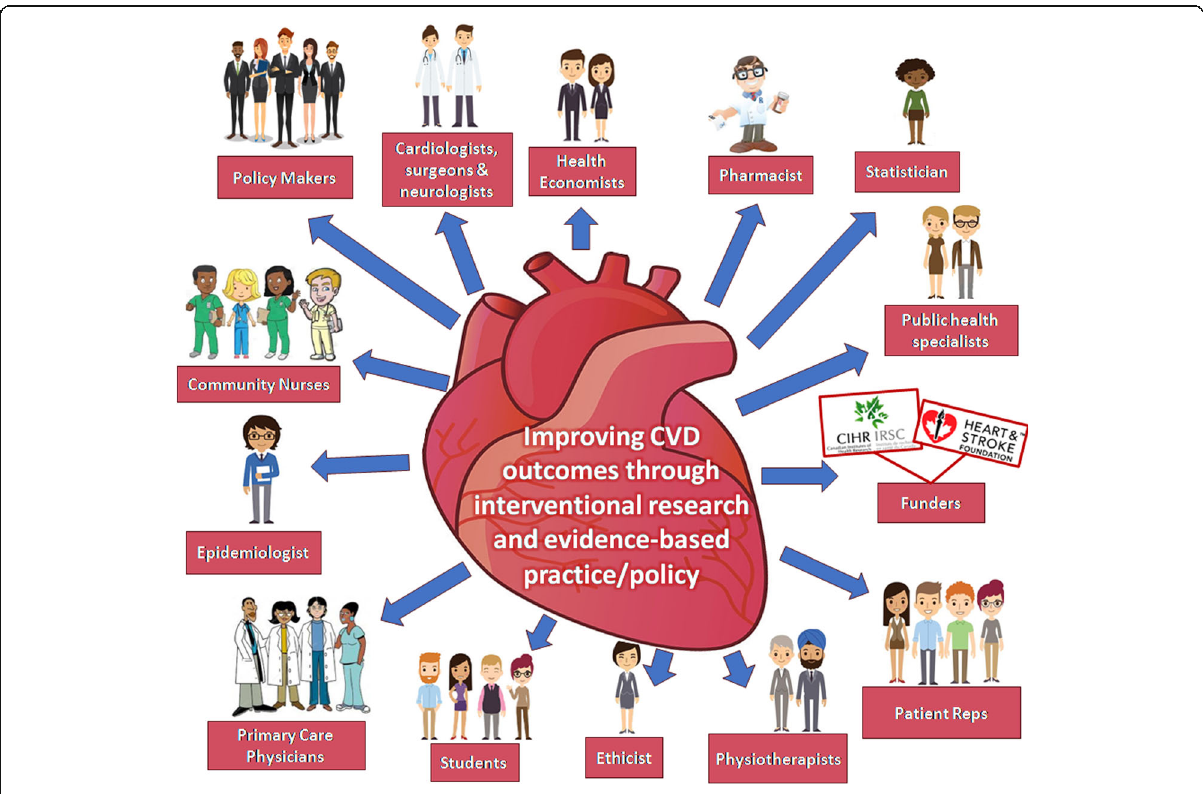
Fig. 1 Example of a cardiovascular health research network